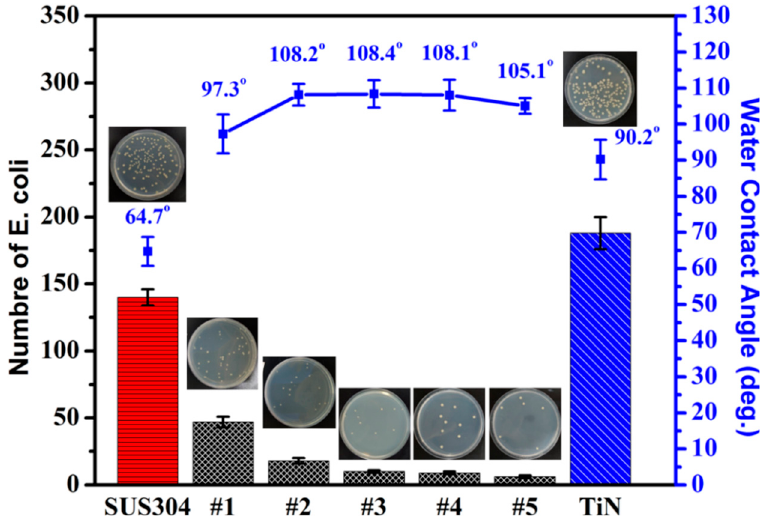
Figure 8. Evolution of contact angle as a function of exposure time under ambient conditions where initial measurements were completed within 3 s.